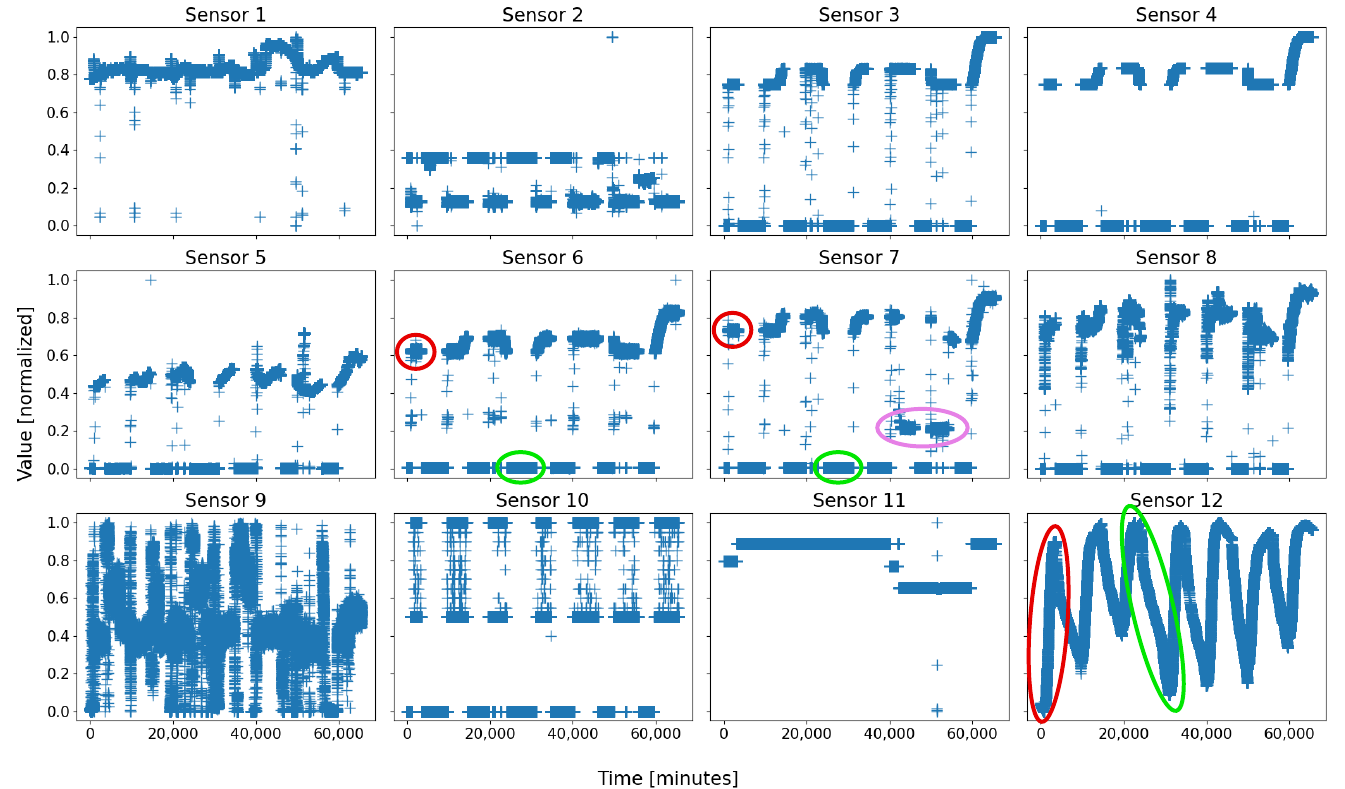
Figure 2. Battery 2 ( D 2 ) sensors over time. Similar to battery 1 (Figure 1), two main motifs stand out, circled in red and green, and a pair of both represents, anew, a regular work week, with the steady state in green and the offline state in red, respectively. A third group of data, circled in pink, is also noticeable: it represents an irregular event that occurred during the data